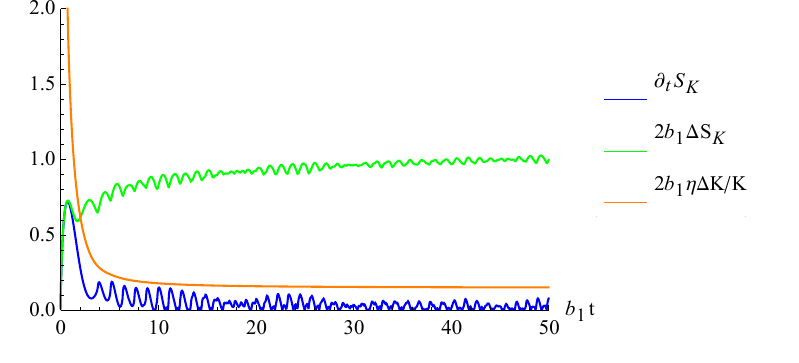
∆ K/K ≤ ∂ 2 b ∆ S 1 η t S K < 1 K = 2 b ∆ K/K is approached t S K 1 . c